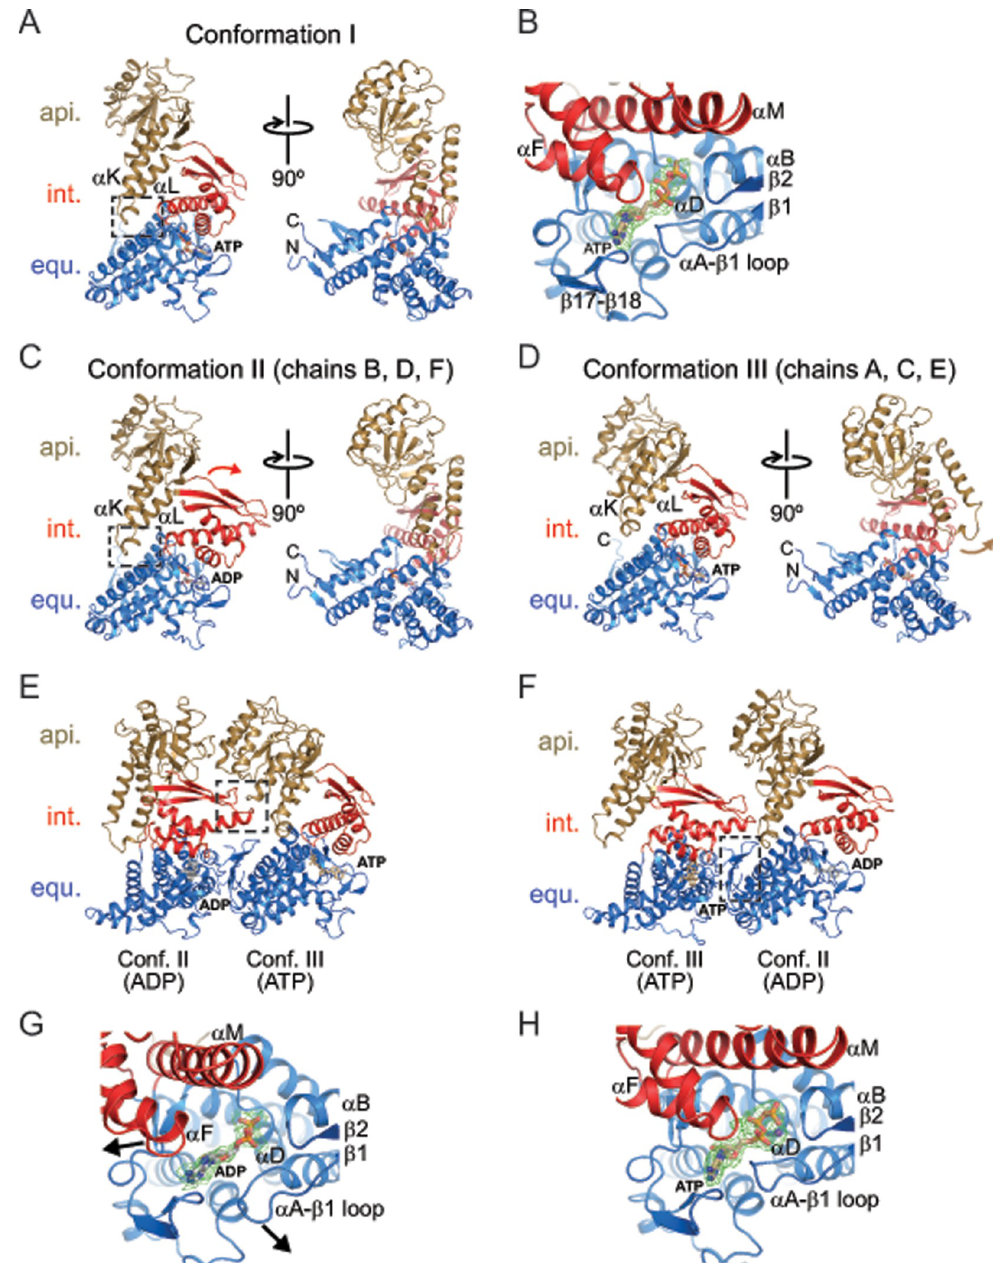
Fig 6. Conformations of ɸ EL subunits observed in the crystal structures. (A) Ribbon representation of ɸ ELsubunit conformation I as observed in chain A of crystal form I. Perpendicular views of ɸ ELare shown. Apical, intermediate and equatorial domain are shown in gold, red and blue, respectively. Bound ATP is shown in stick representation. The intramolecular contact between apical and equatorial domain is highlighted by a box. The α K- α Lhairpin is indicated. N- and C-termini are indicated. (B) Zoom-in on the bound ATP and Mg 2+ in chain A of crystal form I (conformation I). The representation is equivalent to panel A. Unbiased F o- F comit density at 2.85 σ for the nucleotide is shown in green as meshwork. Secondary structure elements involved in contacts to the nucleotideare indicated. (C) Ribbon representation of ɸ ELsubunit conformation II as observed in chain D of crystal form II. The rotation of the intermediate domain (red) compared to conformation I is indicated by a curved arrow. The intramolecular contact between apical and equatorial domain is highlighted by a box. Bound ADP is shown in stick representation. (D) Ribbon representation of ɸ ELsubunit conformation III as observed in chain A of crystal form II. The rotation of the apical domain (gold) compared to conformations I and II is indicated by a curved arrow. Bound ATP is shown in stick representation. (E) Contact between subunits in conformations II and III, as observed between chains E and D in crystal form II. The characteristic intermediate-apical domain